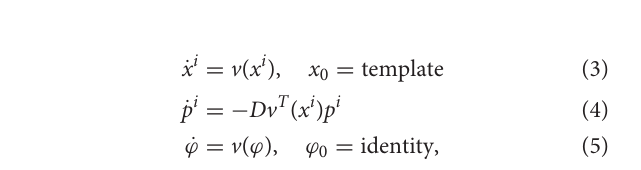
FIGURE 2 | An example of the subcortical gray matter structures studied in this work are shown. They include left and right amygdala, caudate, hippocampus, globus pallidus, putamen, and